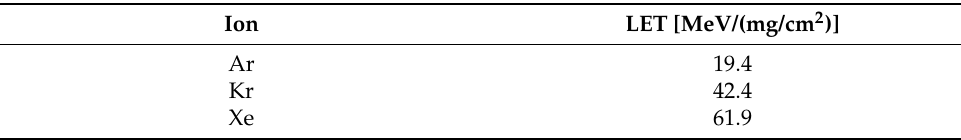
Table 3. Ion species and LET values.